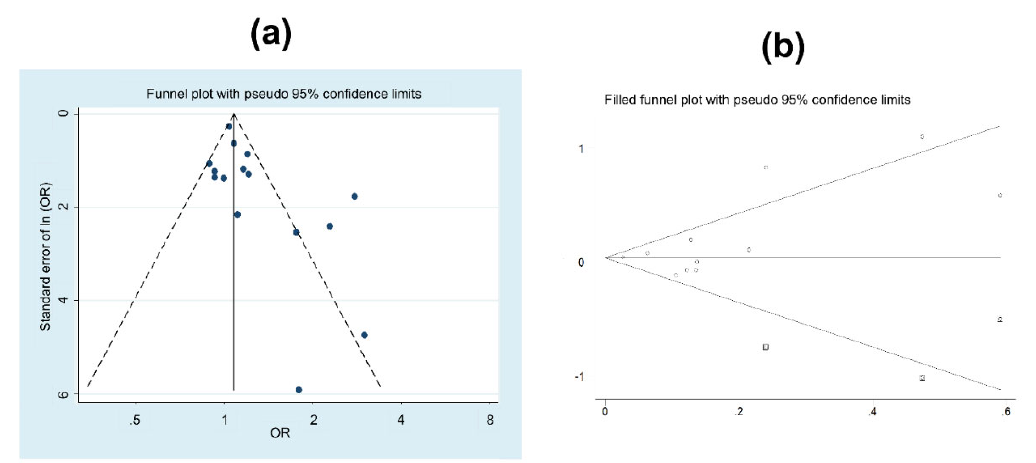
Figure 4. ( a ) Funnel plot of the studies analysing prostate cancer and shift or night work. ( b ) Symmetric funnel plot for the estimation of the studies needed to solve the publication bias.